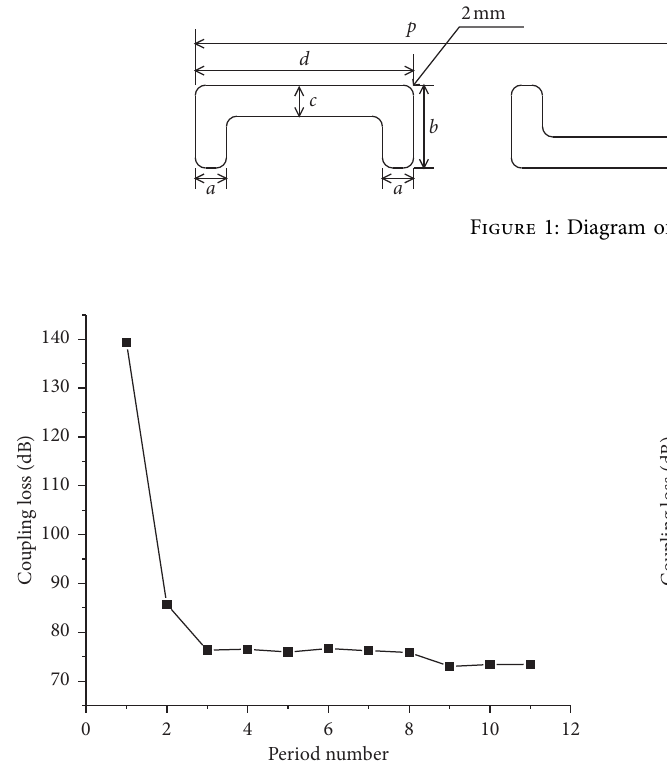
Figure 4: Coupling loss of U-groove leakage